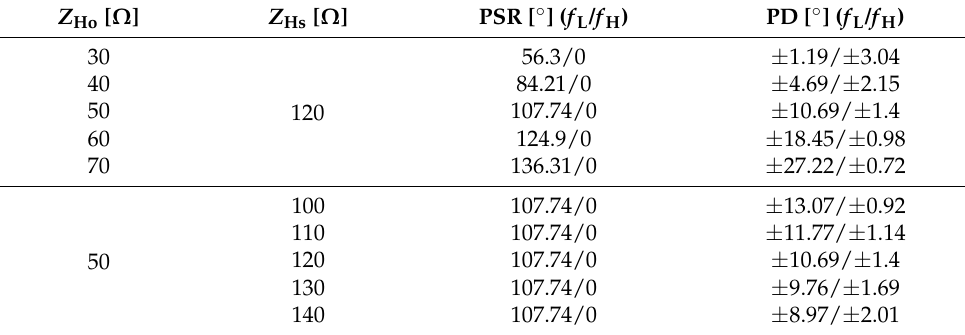
L ( C v = 3.5 to 0.3 pF @ f L